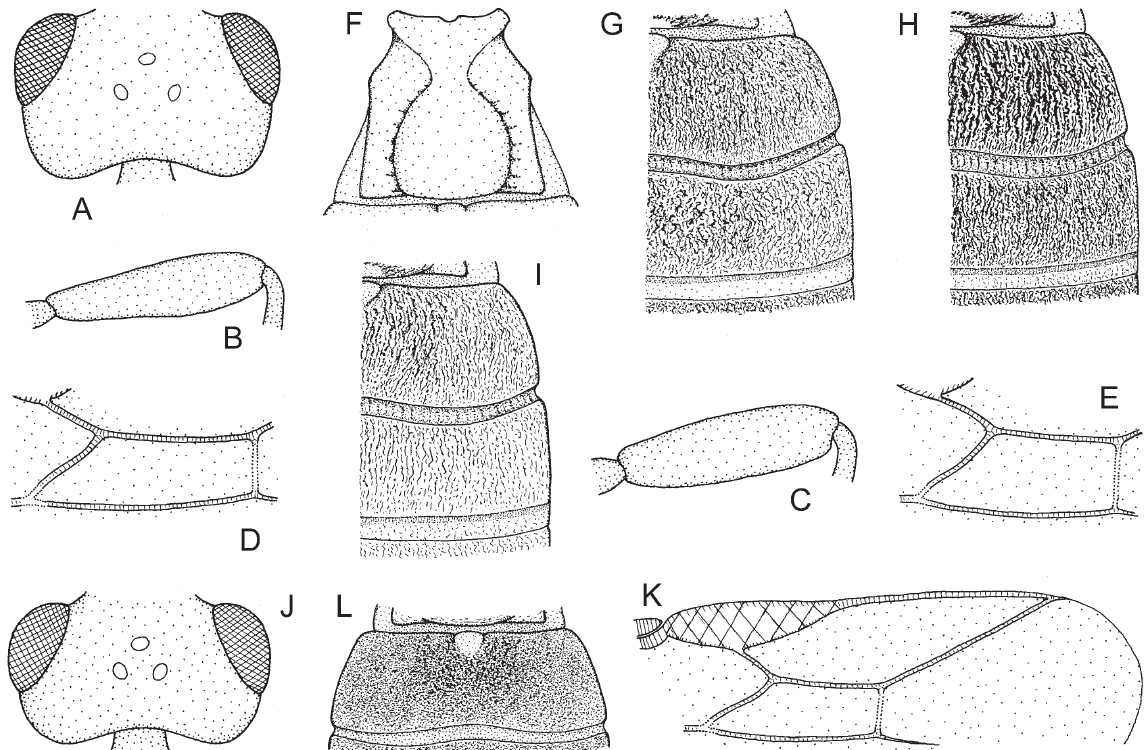
Fig. 35. — A-I . Bracon ( Bracon ) pectoralis Wesmael, 1838 (A: ♀ / ♂, B-G: ♀, H-I: ♂). A . Head in dorsal view. B-C . Hind femur. D-E . Second submarginal cell of forewing. F . First tergite. G-I . Right half of tergites 2-3. — J-L . Bracon ( Bracon ) mesasiaticus Tobias, 1957, ♀ paralectotype. J . Head in dorsal view. K . Distal part of right forewing. L . Second